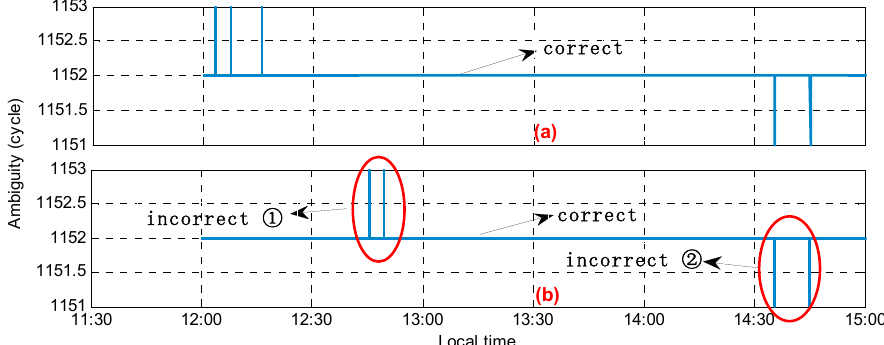
Figure 11. The performance for the fixed ambiguity for satellite C04 ( a ) without ambiguity validation and ( b ) with ambiguity validation.